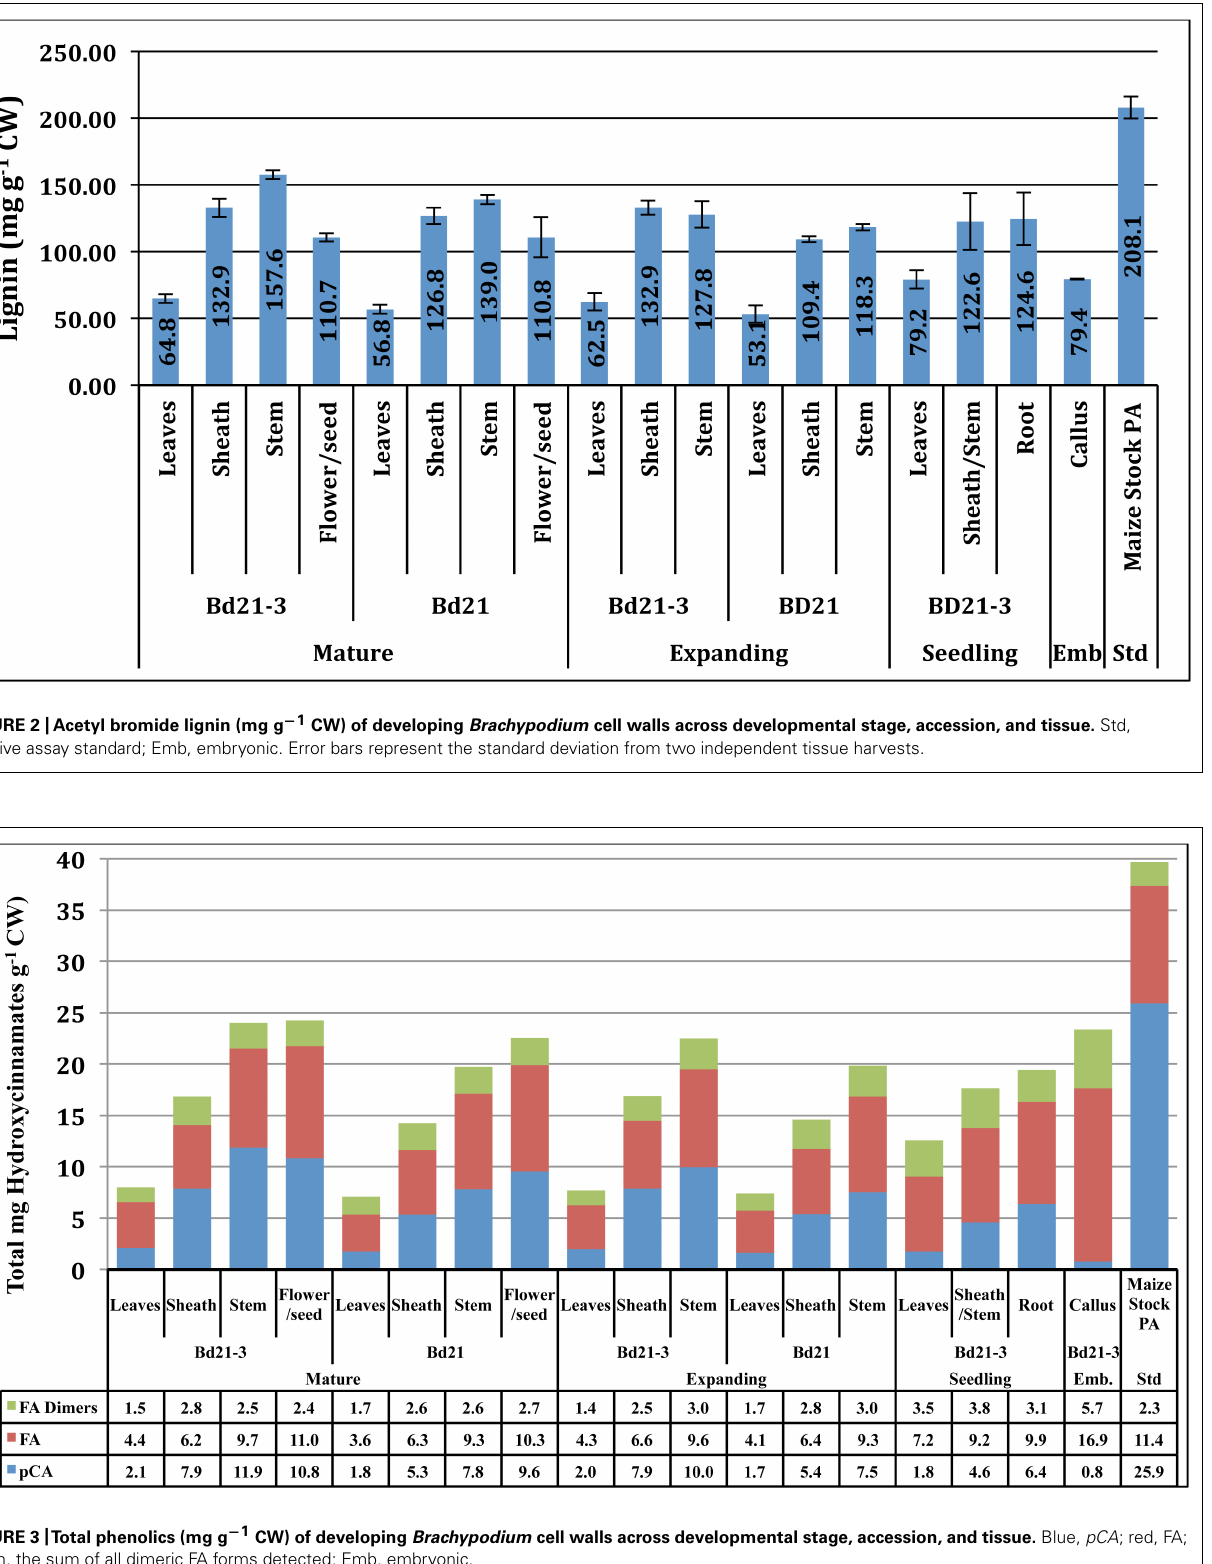
Frontiers in Plant Science | Plant